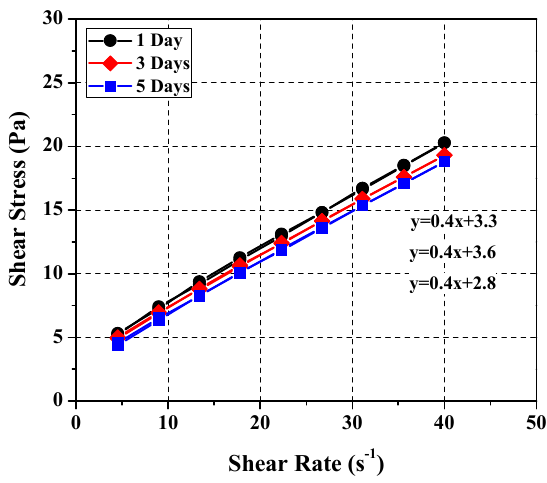
Figure 5. Test results of rheology for ages.